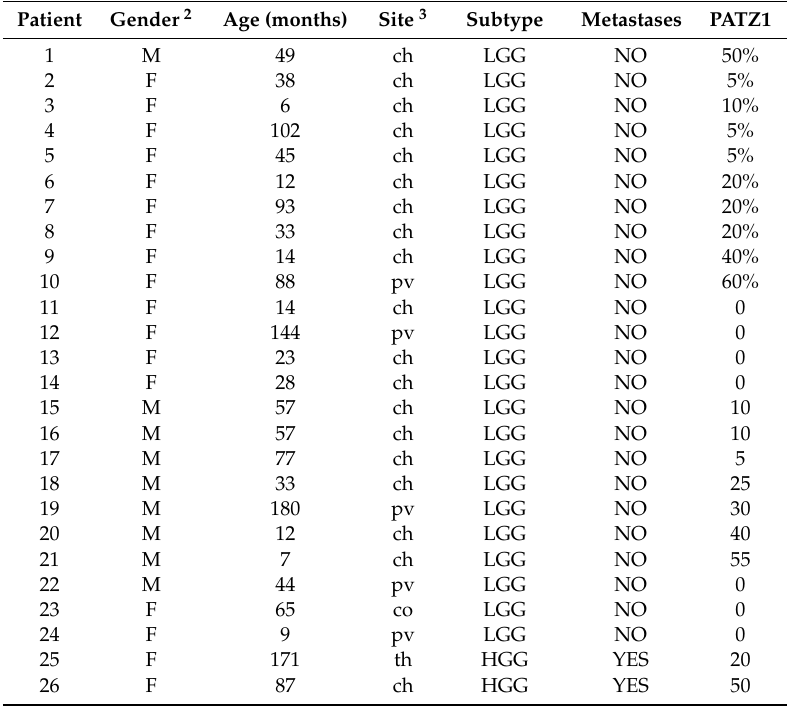
Figure 2. Immunoreactivity score in pediatric gliomas stained for PATZ1. ( a ) Representative perilesional normal cortex: only neurons stain positively, while glial cells are negative. ( b ) Representative pLGG scored low ( ≤ 10% PATZ1-positive cells). ( c ) Representative pLGG scored high ( > 10% PATZ1-positive cells). ( d ) Representative pHGG scored low. ( e ) Representative pHGG scored high. ( f ) Fraction of total PATZ1 scores in pLGG and pHGG. Percentage of high PATZ1 expression is indicated. Discrepancy was significant according to the binomial test. * p < 0.05. Table 2. Clinicopathological features and PATZ1 expression of 52 pediatric gliomas. 1